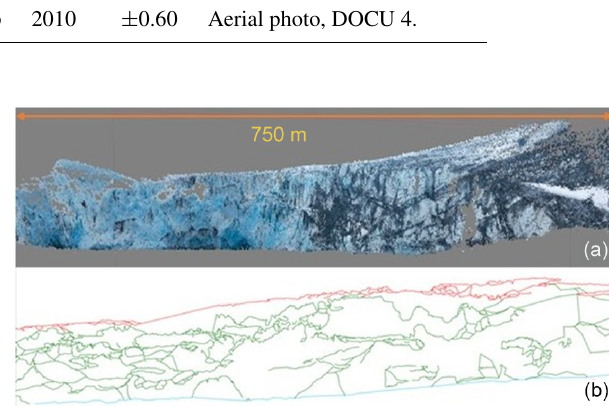
Figure 7. (a) Orthophoto of Johnsons Glacier calving front. This point cloud is made up of 180000 points obtained by automatic correlation. (b) Johnsons Glacier calving front: in the upper part, in red, the uppermost line of the calving front, obtained by photogram- metric restitution; in the lower part, in blue, the